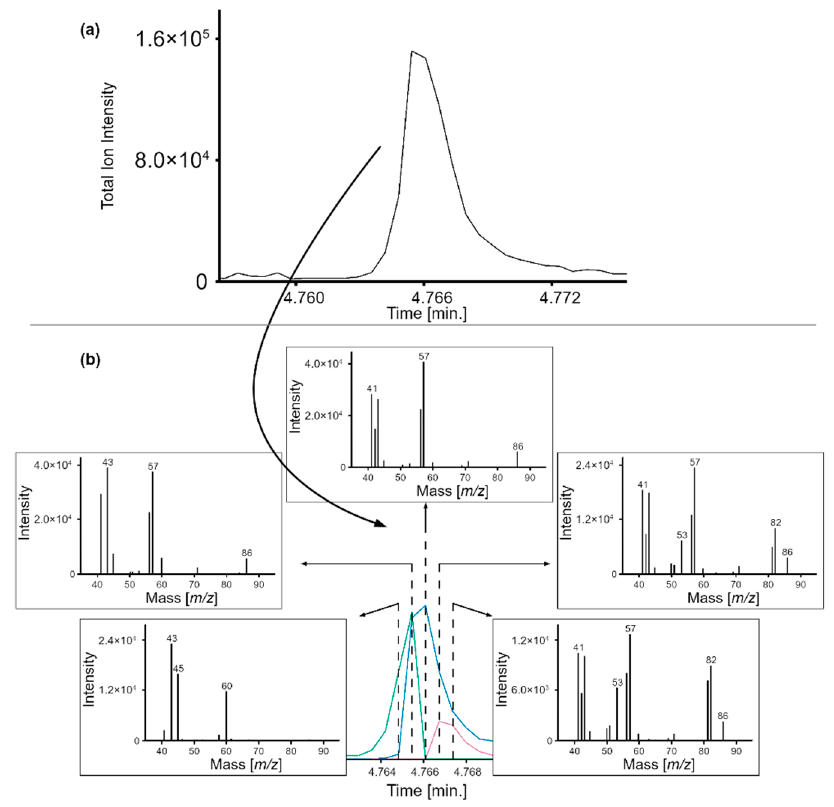
Figure 3. ( a ) Targeted analysis example of high elevation tea. ( b ) Spectral deconvolution of acetic acid (green), hexane (blue), and 2-methylfuran (pink) ions and relative abundances.